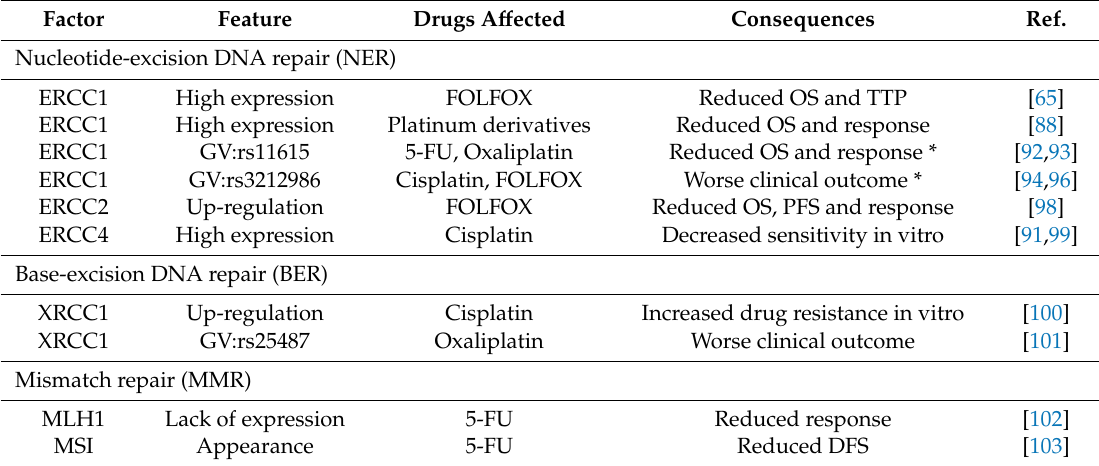
Table 4. Mechanisms of chemoresistance type 4 (MOC-4) to drugs used in the treatment of GAC. Factor Feature Drugs A ff ected Consequences